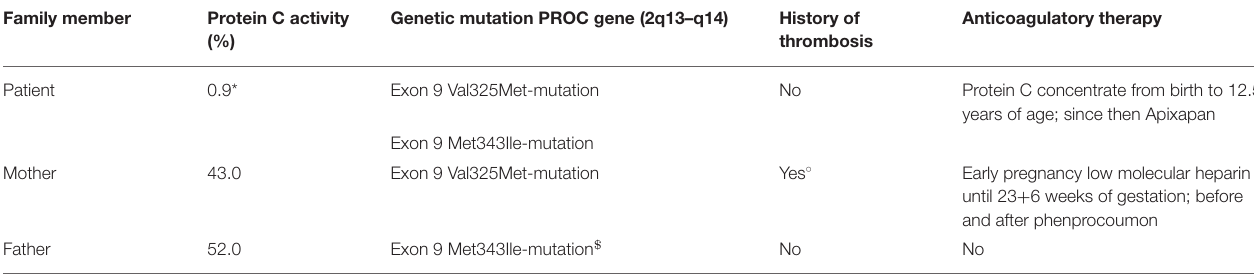
TABLE 1 | Disease-related family history and selected laboratory results.